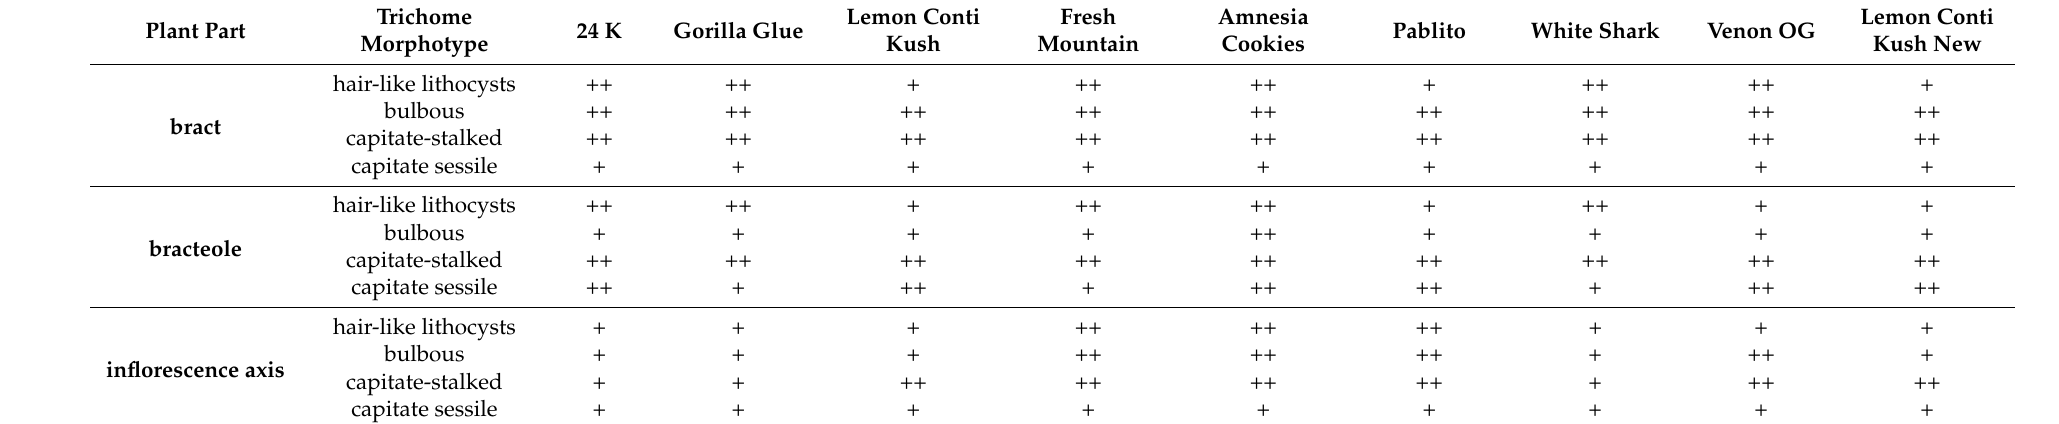
Table 10. Distribution pattern of the glandular and non-glandular trichomes in the examined C. sativa varieties. Plant Part